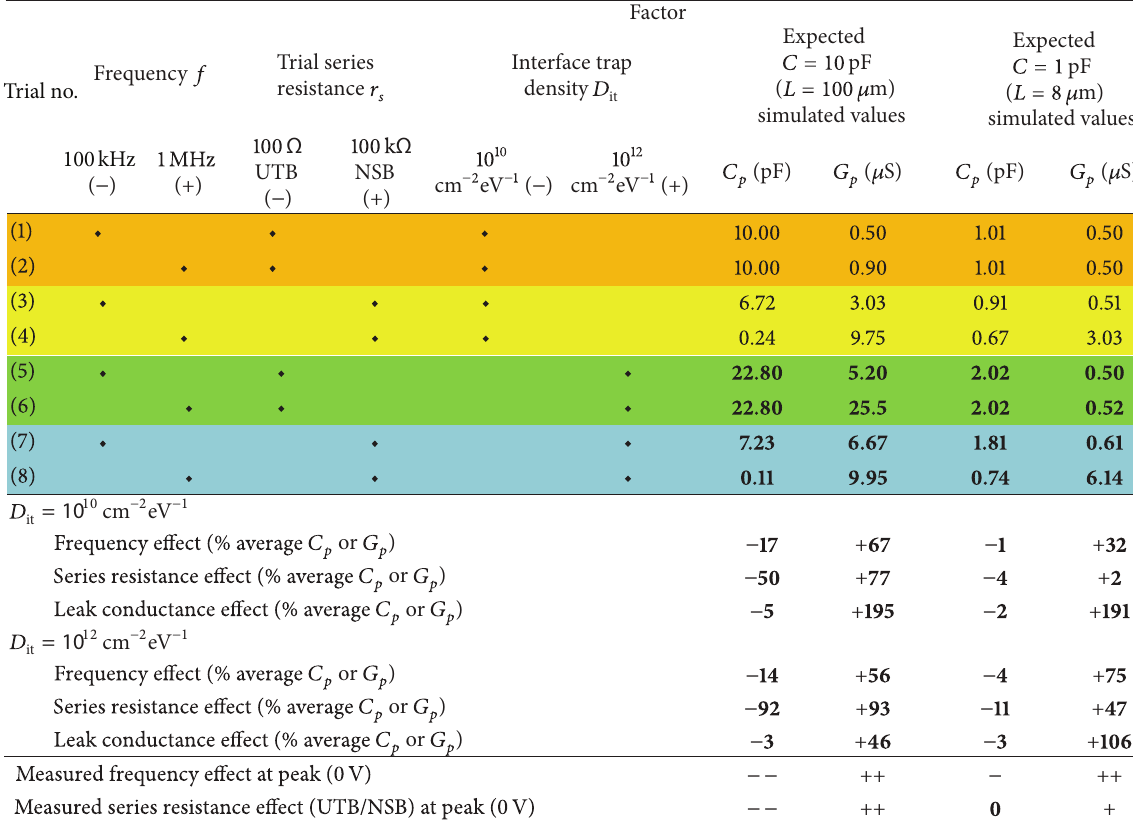
Factor Expected Expected Interface trap pF pF density ( m) ( m) it simulated values simulated values